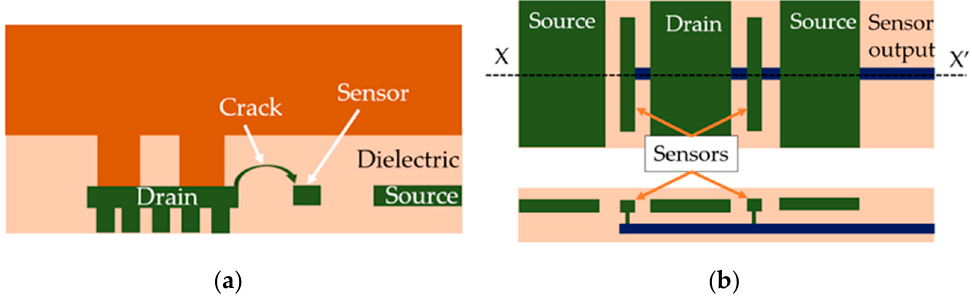
Figure 4. IMD crack sensor: ( a ) the working principle; ( b ) top view of the comb-like structure and cross-section along the XX’ axis;.